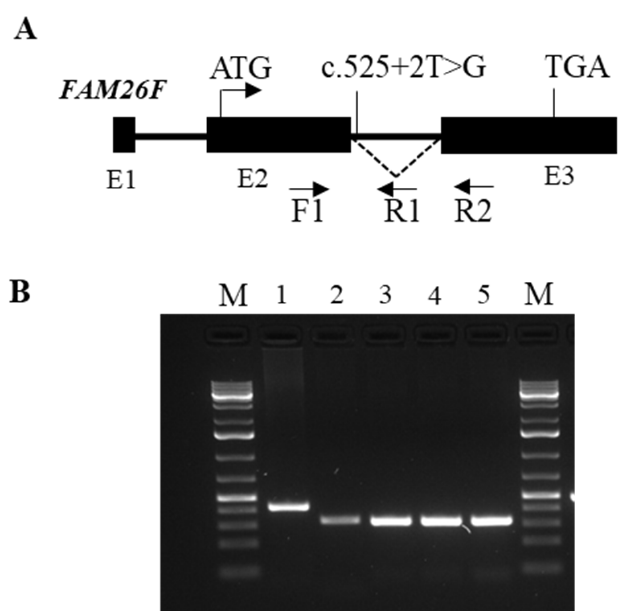
Figure 5. FAM26F gene structure and expression of the aberrant transcript. ( A ) Genomic structure of the human FAM26F gene. Exons are indicated by dark rectangles, introns with bold lines. The start site and stop codon are present in exons 2 and 3, respectively. The splicing mutation in intron 2 is indicated. Primers used in the expression analysis are indicated with arrows. ( B ) RT-PCR anal-